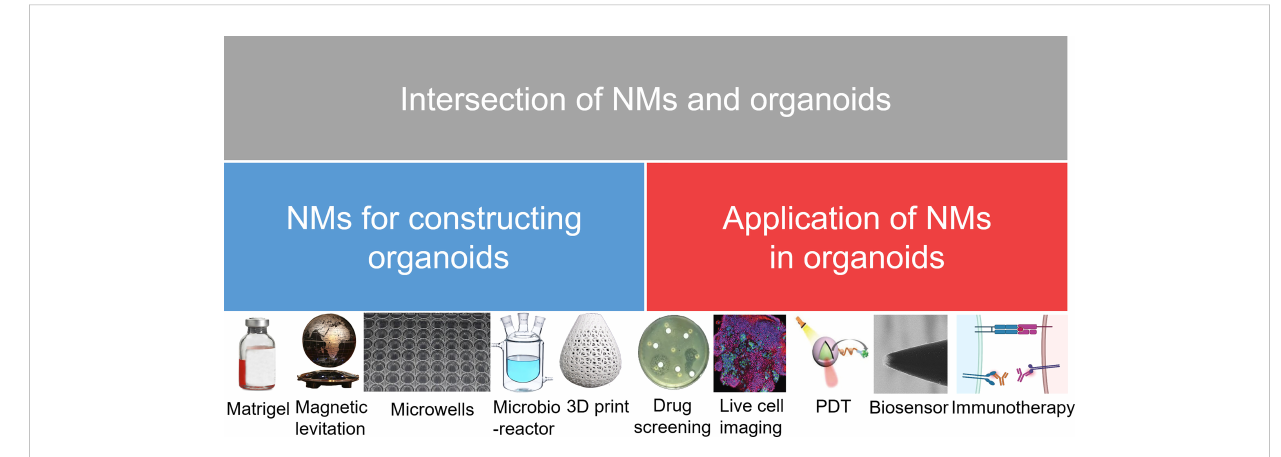
FIGURE 1 Research directions in the development of NMs and organoids. NMs, nanomaterials; PDT, photodynamic